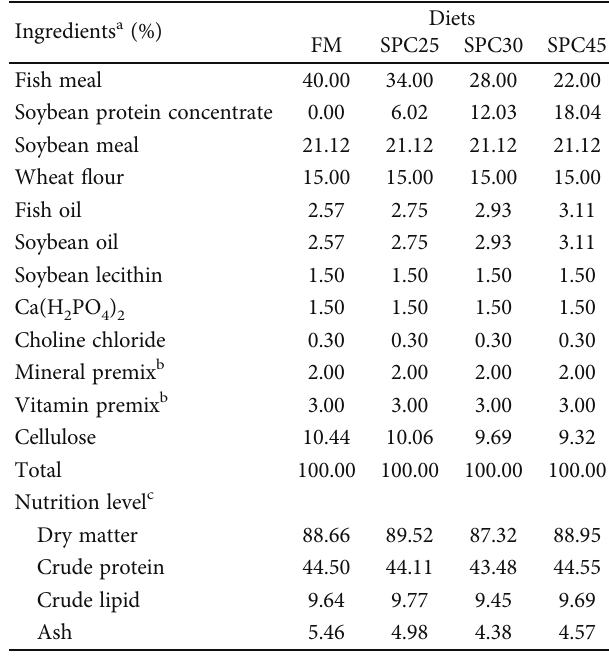
Table 1: Formulation and proximate composition of the experimental diets (dry